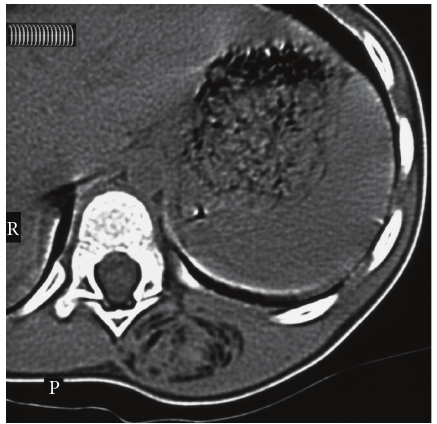
Figure 2: Axial CT image demonstrating a paraspinal mass composed of a mixture of fat and muscle. No bony involvement noted.